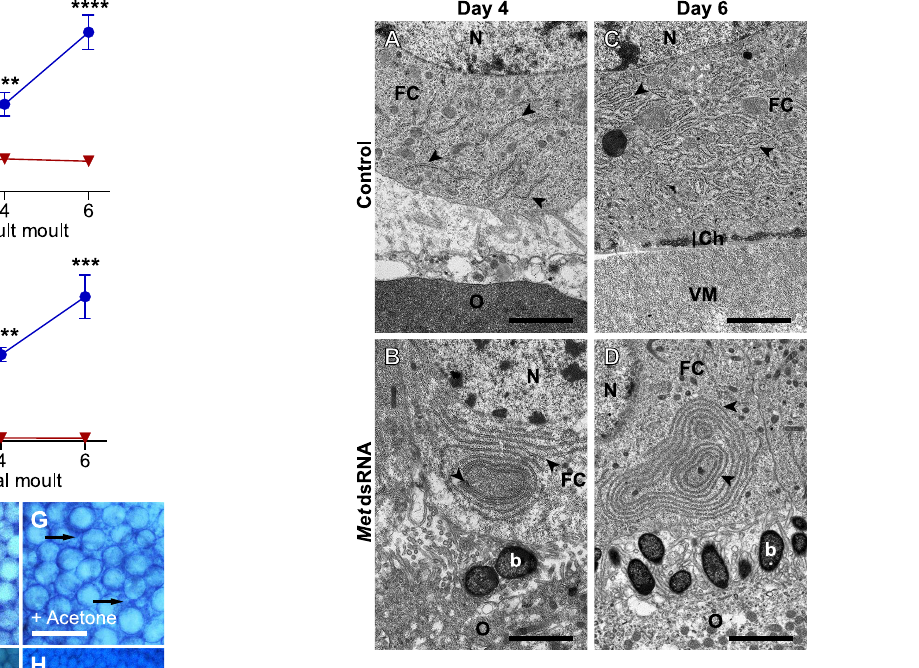
Figure 6. Follicle cell ultrastructure is affected by DippuMet dsRNA-treatment. Transmission electron micrographs of the interface between follicle cells (FC) and oocytes (O) from control animals undergoing vitellin uptake (A), early chorion (Ch) formation (C), and DippuMet dsRNA-treated animals undergoing autophagic vacuole formation on day 4 (B) and day 6 (D). Plates show the nucleus (N), rough endoplasmic reticulum (arrowheads), bacteroides (b) and vitellin membrane (VM). A – D are shown at the same magnification; scale bars indicate 2 m m.